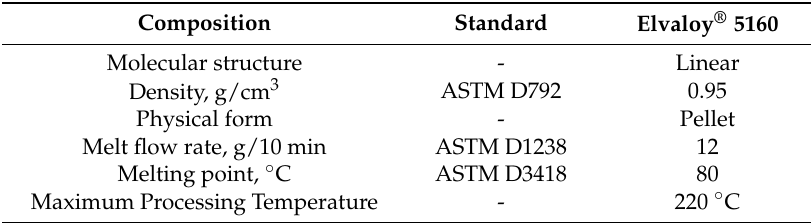
Table 2. The physical properties of Elvaloy ® 5160